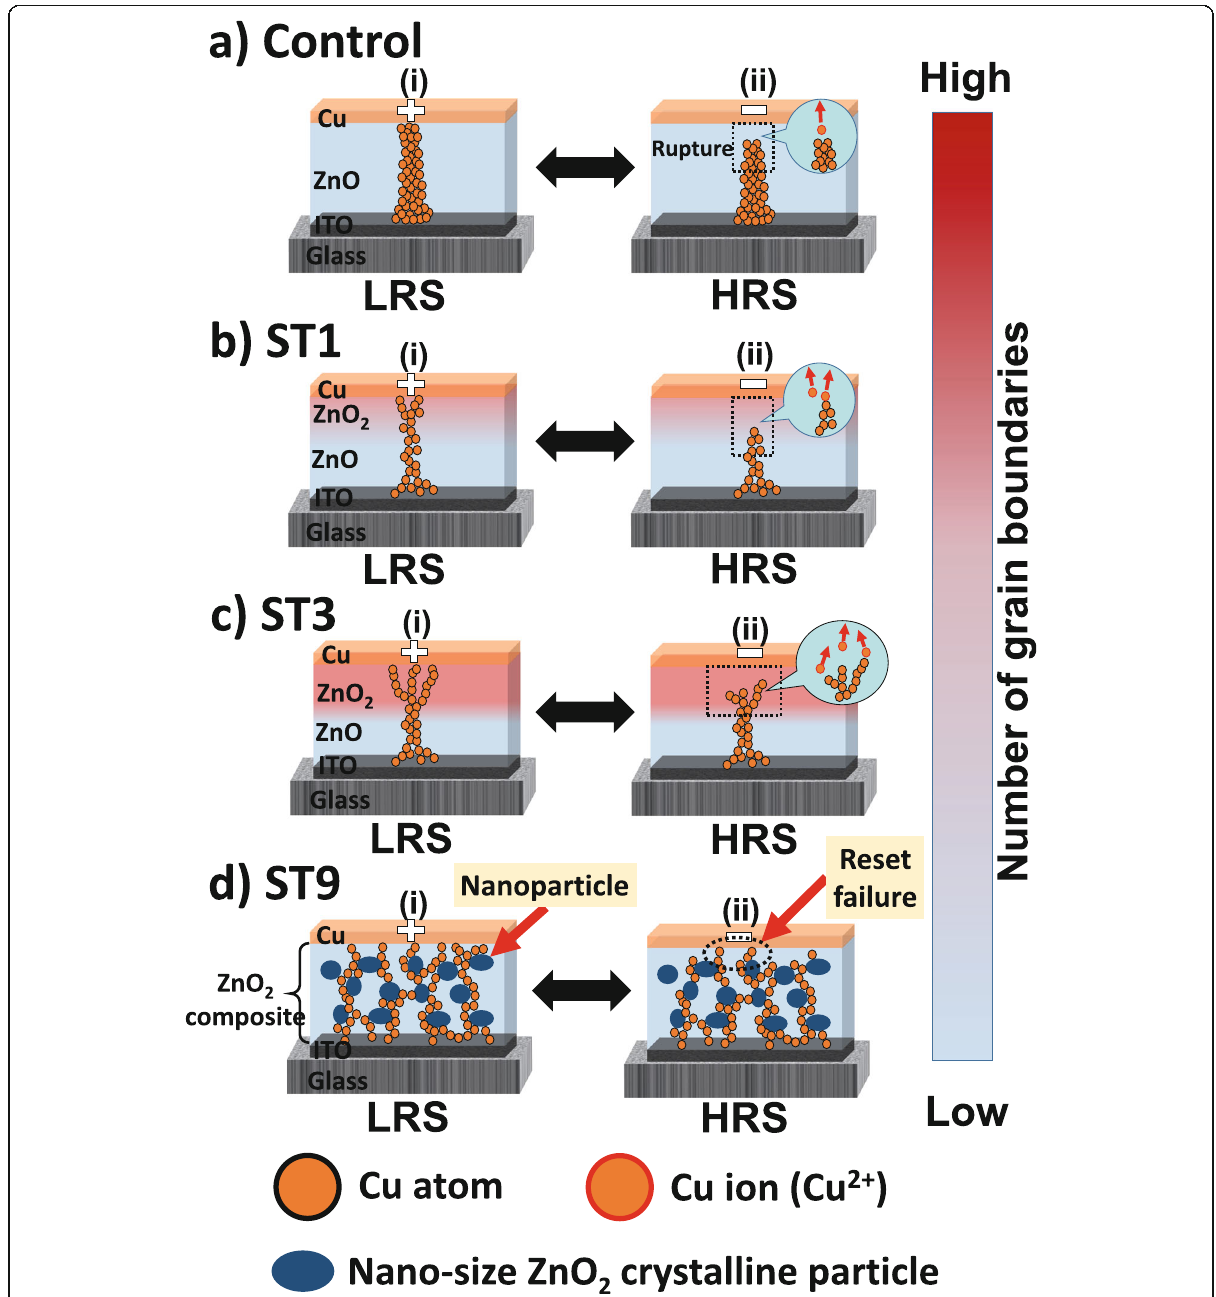
Fig. 4 Schematics of conduction mechanism of ( a ) control, ( b ) ST1, ( c ) ST3, and ( d ) ST9